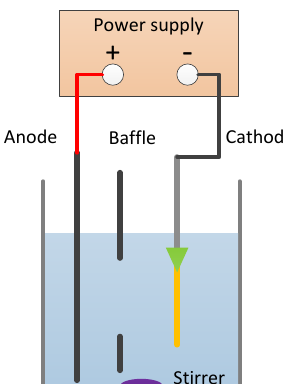
Figure 4. Schematic illustration of the electroplating solution with the anode of Cu plate and the cathode of the silicon wafer.